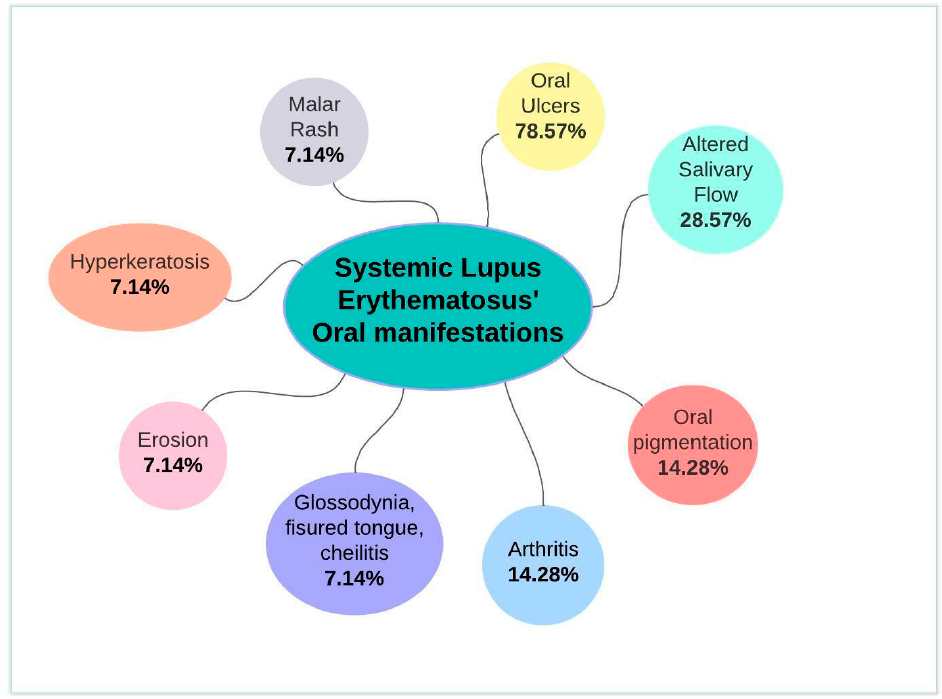
Figure 2. Summary of systematic lupus erythematosus’ oral manifestations. Table 3. Oral signs and symptoms and their significant association.